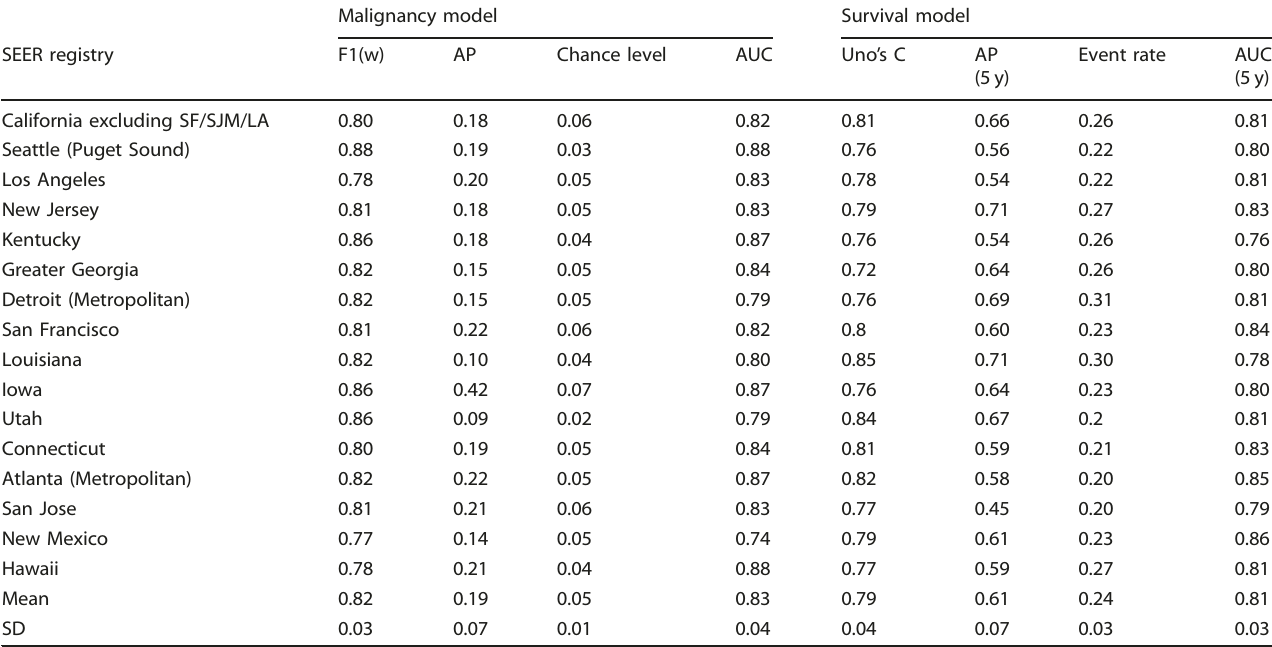
Table 1. Summary of performance metrics for the malignancy and survival models per SEER registry (for all registries with at least 100 cases) as evaluated on the